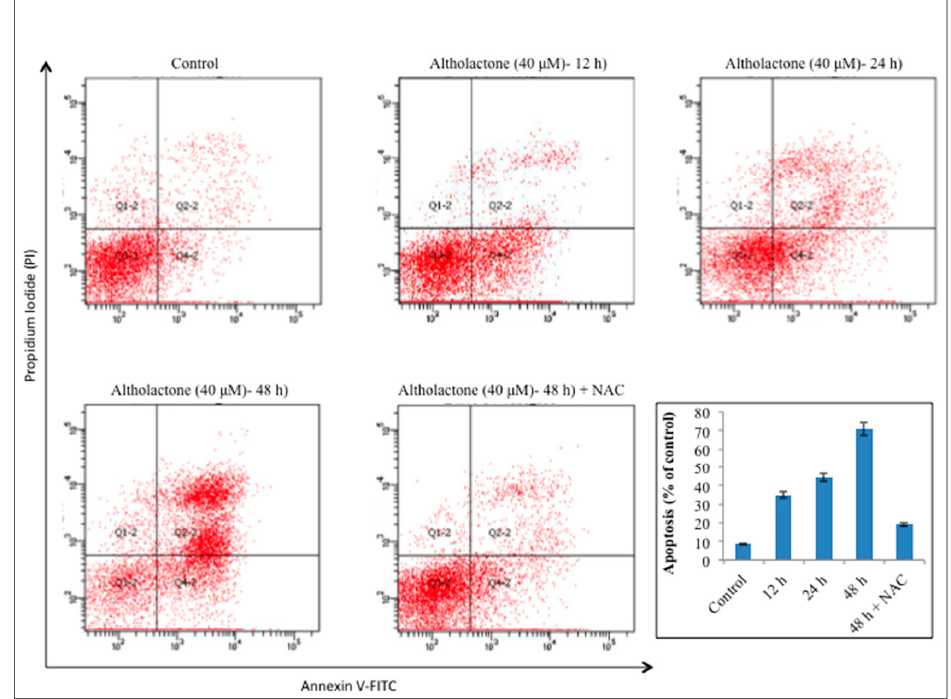
Figure 3. Apoptosis induced by altholactone in DU145 cells. The prostate cancer DU145 cells were treated with 40 µM of altholactone (AL) for 12 and 24 h or in the presence or absence of NAC for 48 h. Then cells were stained with FITC-conjugated Annexin V and PI for flow cytometric analysis. The flow cytometry profile represents Annexin V-FITC staining in x axis and PI in y axis. Data are representative of three independent experiments and are expressed as mean ± SD ( n = 3).